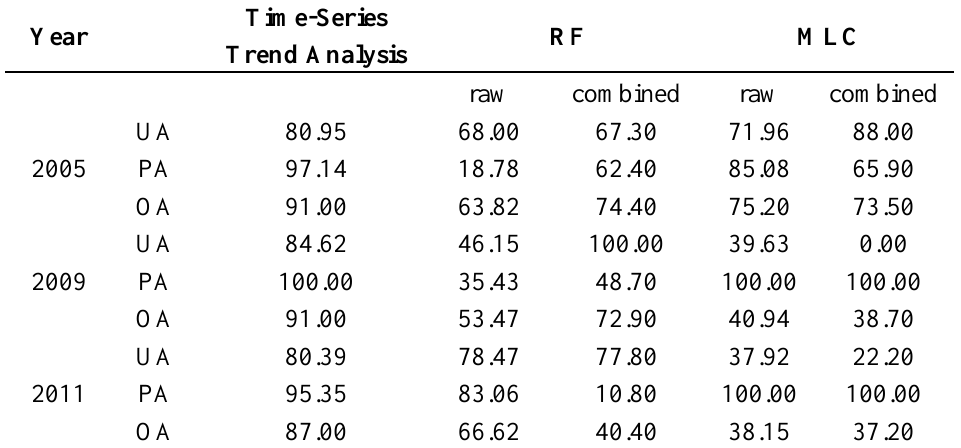
Table 7. Accuracy comparison among the time series classification, random forests (RF) and maximum likelihood classifier (MLC) with the same set of 2005, 2009 and 2011 validation samples. Only the mountain pine beetle (MPB) mortality class is included